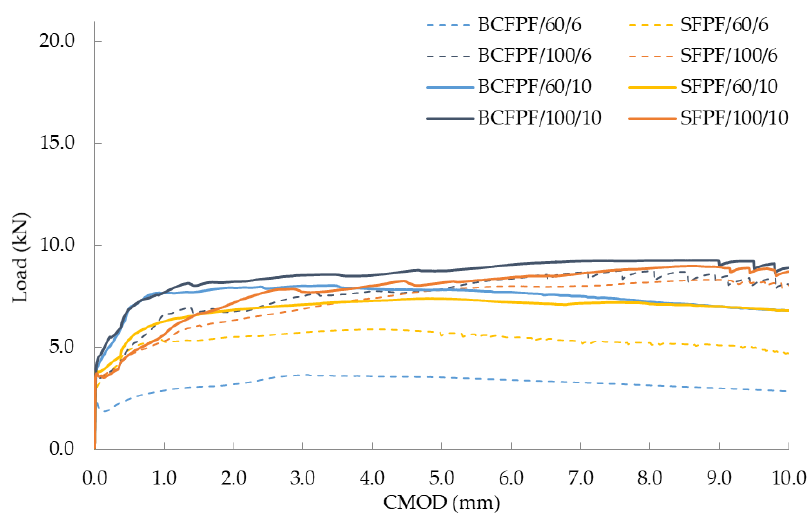
Figure 6. Load—CMOD (crack mouth opening displacement) relationship graphs for 400/1.6 matrix after 28 days of curing.